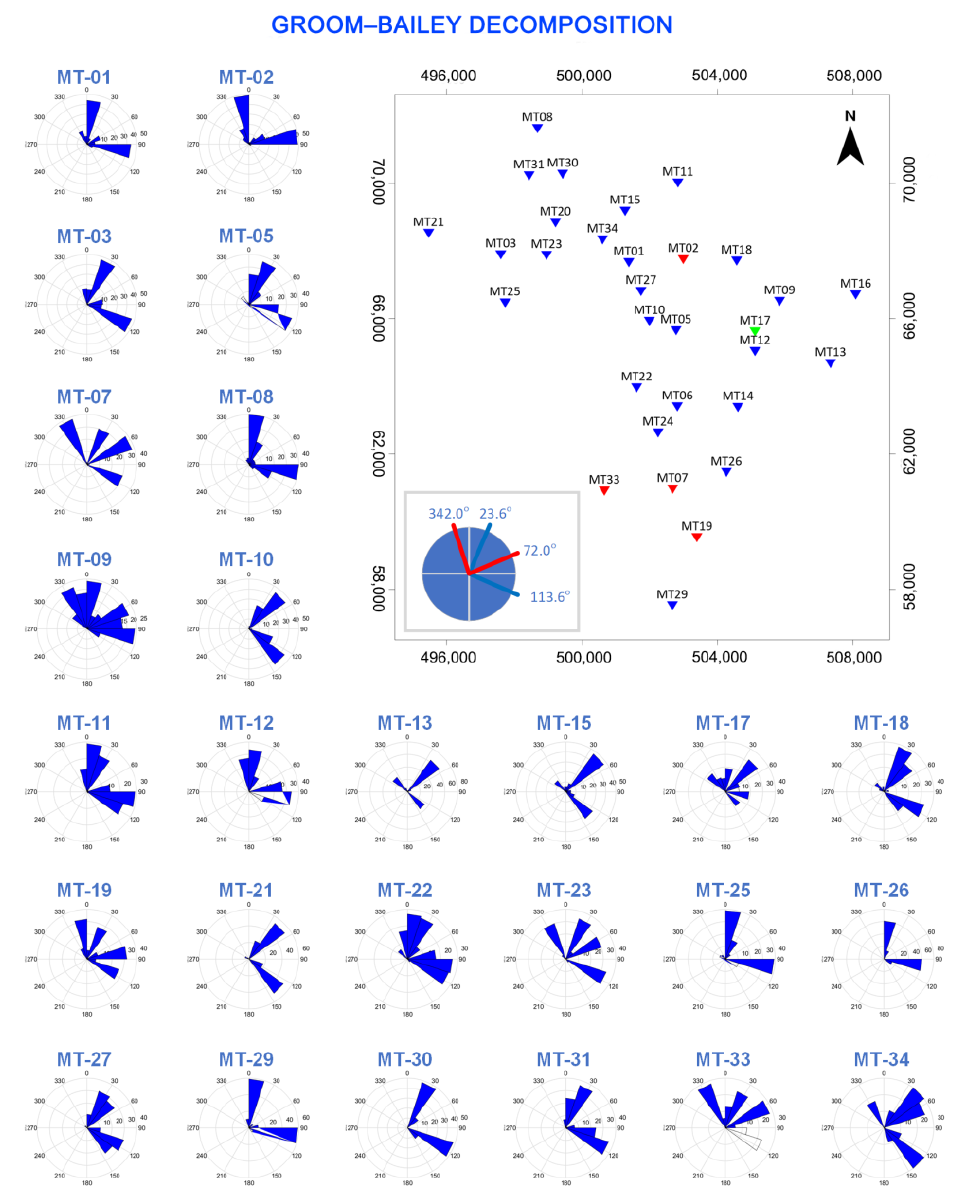
Figure 5. Regional conductivity strike direction of the Limboto Lake—Pentadio area based on Groom–Bailey decomposition technique.